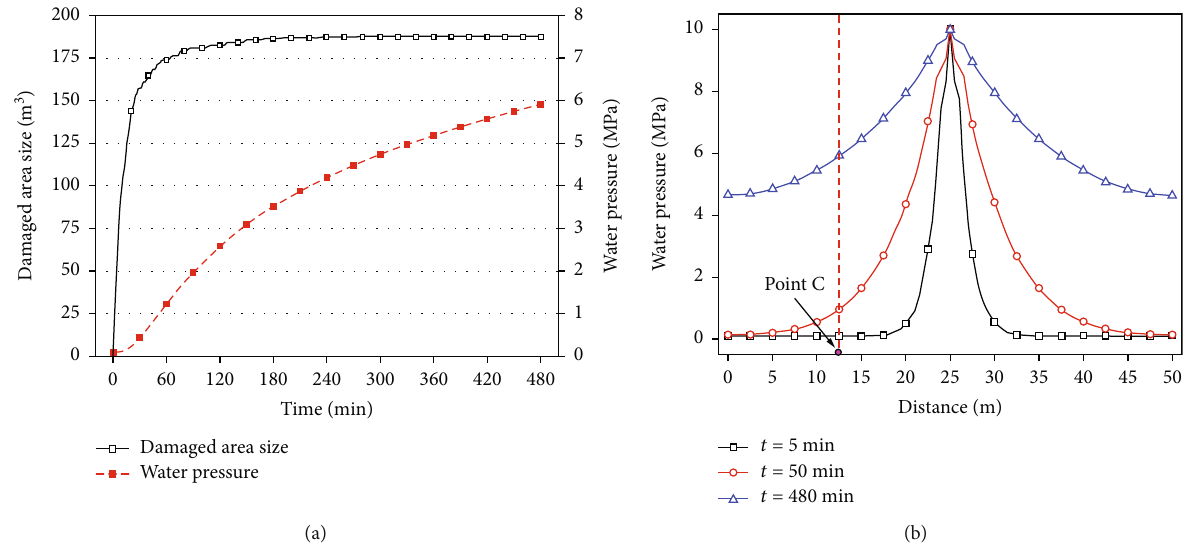
Figure 15: Damaged area size and water pressure: (a) damaged area size and water pressure at point C and (b) water pressure of line AB.